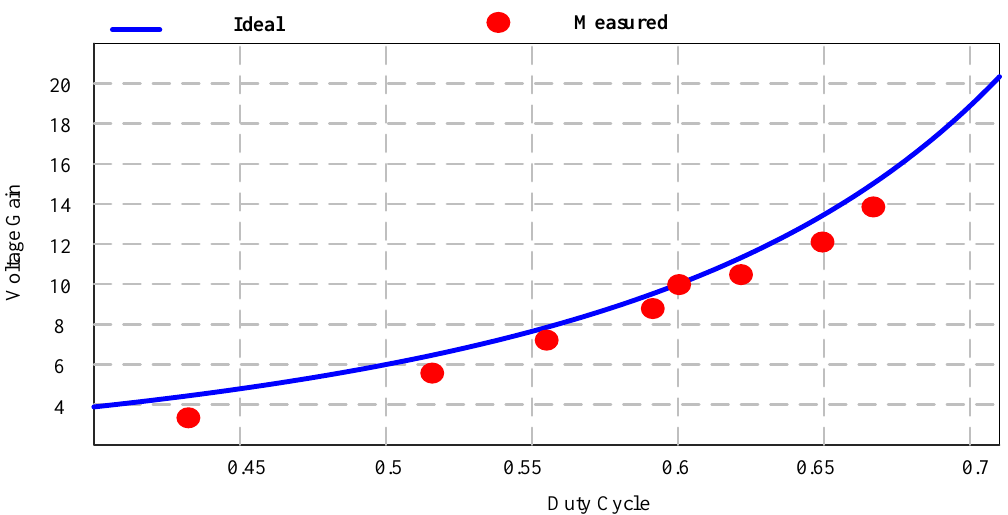
(b) Figure 16. The switching and conduction losses distribution—( a ) element losses distribution; ( b ) total losses distribution. Figure 17 illustrates the relation between the calculated and measured converter volt- age gain; the results are consistent and the slight differences are due to the effect of the losses on the converter voltage gain. Efficiency is a major factor in selecting a converter for a specific application, and achieving higher efficiency at a higher voltage gain is a de- sirable factor for some applications, such as for PV microconverters. Figure 18 is a depic- tion of the efficiency of the proposed converter, with the input voltage set to 20 V and the duty cycle set to 0.6; the voltage gain at this point is around 10 times that illustrated in Figure 13. Converter efficiency improves by increasing the input power. Efficiency at 175